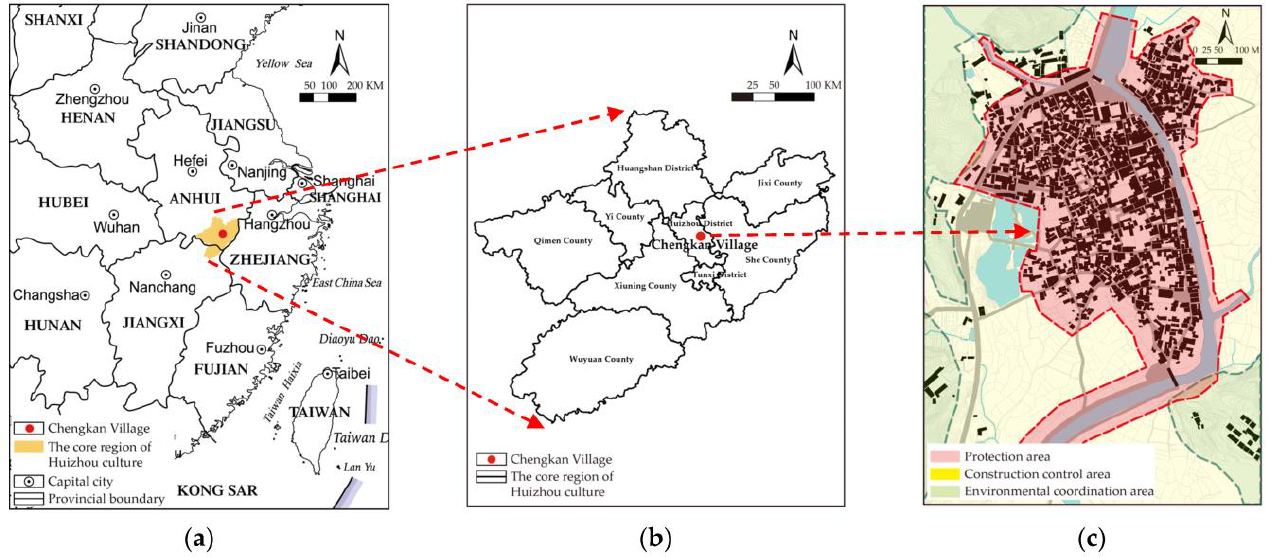
Figure 1. Identification of the study area. ( a ) The Huizhou culture region in Anhui. ( b ) The Chengkan Village in Huizhou culture region. ( c ) The Chengkan Village conservation planning.